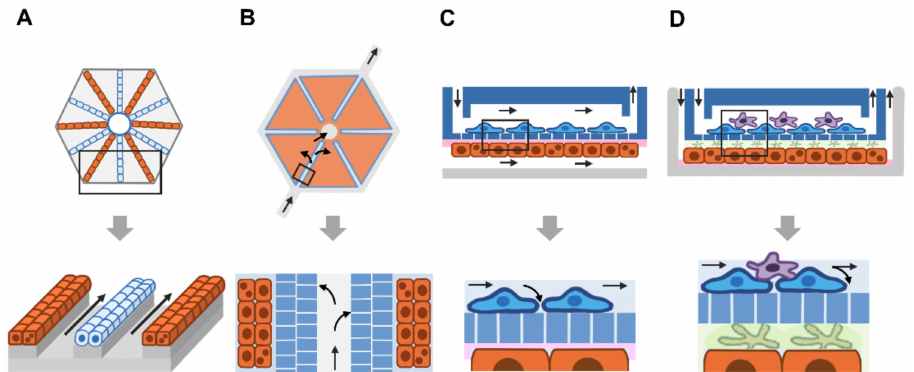
Figure 4. Design of a liver-on-a-chip based on the microarchitecture of the liver lobule. ( A ) The radial pattern of hepatocytes and SECs (light blue-colored ovals) is modeled using electric-based cell seeding. The magnified box shows two lines of hepatocytes and a line of endothelial cells. ( B ) Hexagon-shaped microchip containing six microchambers (red) for cell seeding. The magnified box shows a double porous layer (blue-colored rectangles with white lines) as the fenestrated SECs. Due to their distal and proximal locations to the porous layer of hepatocytes, nutrients and gas diffuse into hepatocytes in a gradient pattern (arrows). ( C ) The two-sided layer allows coculture of distinct cell types. Human primary hepatocytes (orange-colored rectangles) are grown on collagen-coated surfaces (pink), while immortalized bovine aortic endothelial cells are grown in the upper chamber. A porous PET membrane separates the two chambers and allows small molecules to pass through. ( D ) Heterogeneous cell culture in a double microchamber. Human primary hepatocytes (orange-colored rectangles) are grown on the fibronectin-coated surface (pink) of the lower chamber, while the endothelial cell line is grown on the porous PET membrane of the upper chamber. The space between hepatocytes and the porous upper layer is filled with collagen gel (light green) containing hepatic stellate cells (reticular, green-colored shape). The human monocytic cell line U-937 (violet-reticular shapes) was cultured on top of ECs to mimic liver-resident macrophages (Kupffer cells). Arrows indicate the direction of fluid